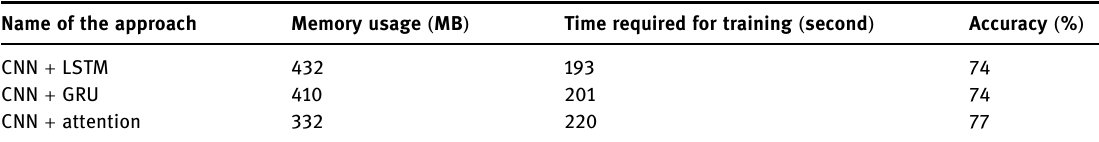
Table 1: Performance comparison of the proposed approach Name of the approach